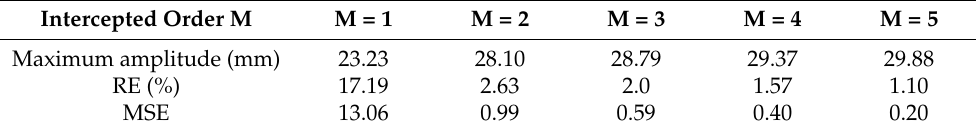
Table 1. Measured amplitude and analyzed amplitude by Fourier series on the midpoint.